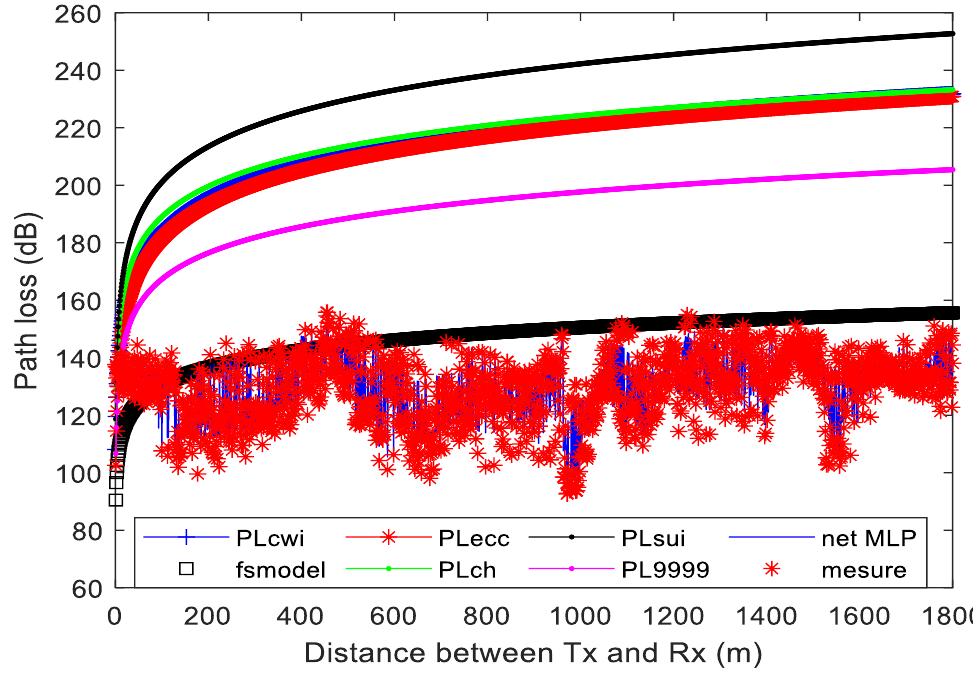
Figure 14. Comparison between empirical models and MLP (with two hidden layers) for Dataset 3.